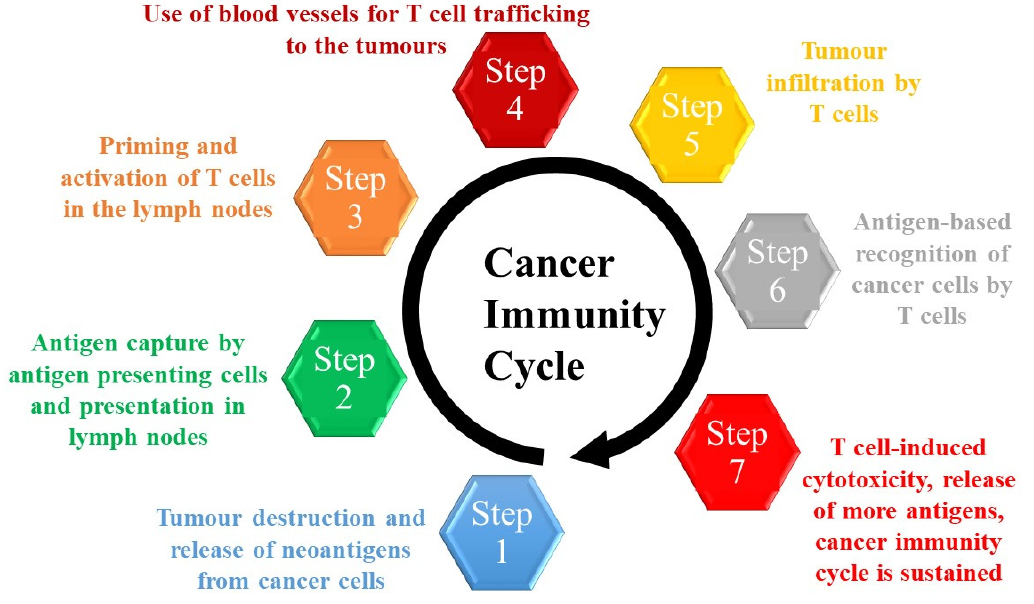
Figure 1. The Cancer Immunity Cycle.